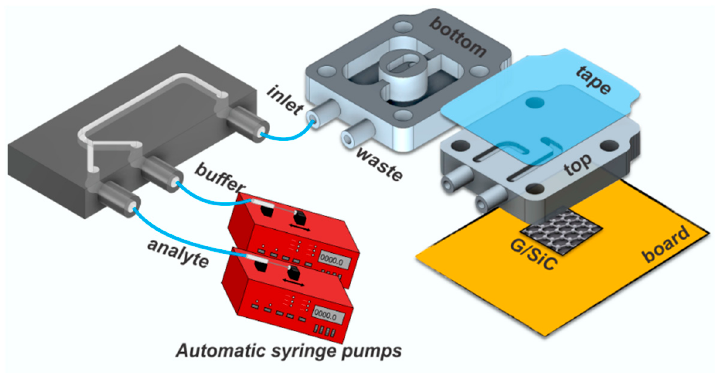
Figure 1. Schematic of the sensing platform.